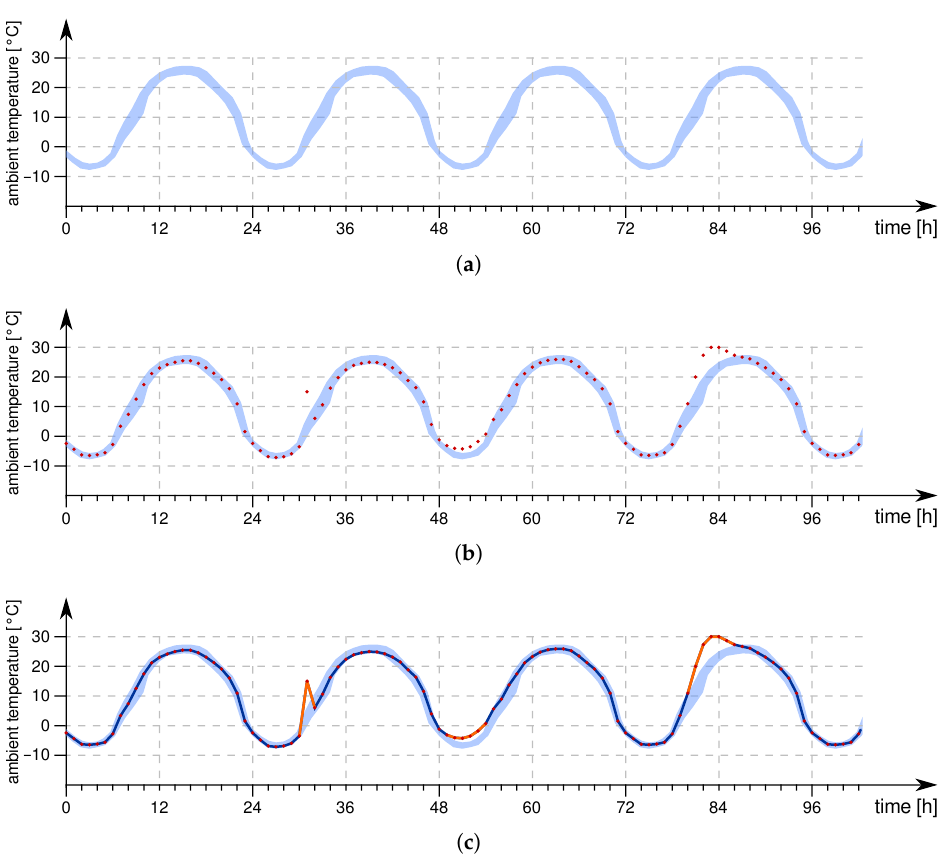
Figure 7. Anomaly detection in an environmental monitoring example. ( a ) Derived model of the “normal” behavior, ( b ) Continuous sensor value updates, ( c ) Data anomalies: soft faults or proper